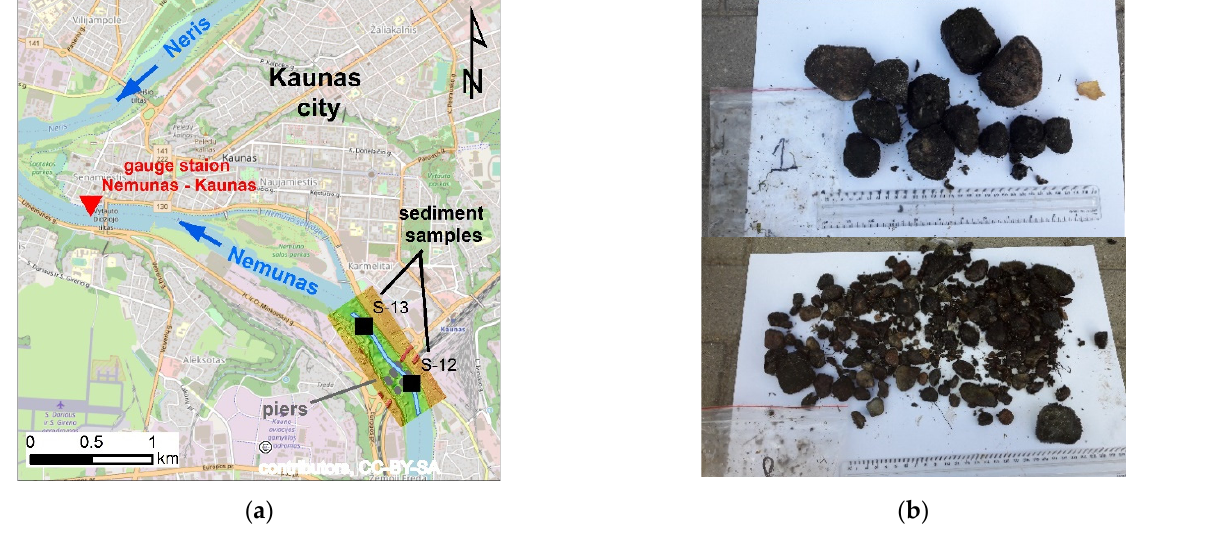
Figure 4. Gauge station and sediment samples: ( a ) location of gauge station and sampling points around the bridge, ( b ) examples of the material taken from the bottom. Table 1. Provided hydrologic information.